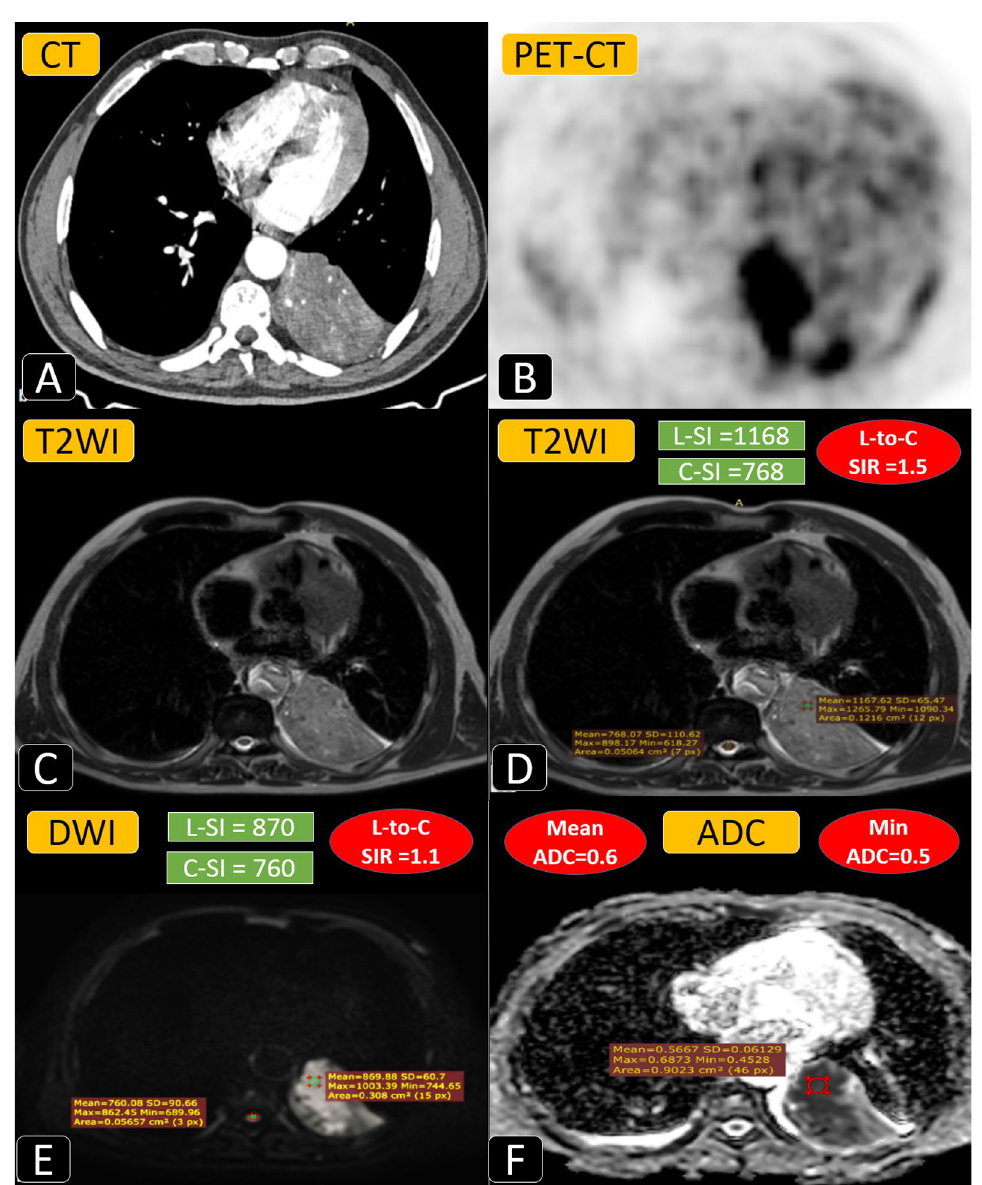
Fig. 5 A 76-year-old male patient complained of hemoptysis and dyspnea. A Axial contrast-enhanced chest CT cut (mediastinal window) showed left medial basal consolidation collapse with internal CT-angiogram and absent air bronchogram with a suspected iso-dense mass lesion. B Axial chest PET-CT image showing high 18F-FDG uptake at most of the lesion. C, D Axial T2WI shows the high signal intensity of the lesion. After placing two ROIs within the largest lesion and the spinal cord, the lesion-to-spinal cord signal intensity ratio was calculated 1.5. E Axial DWI showing = bright signal of restricted diffusion and lesion-to-spinal cord signal intensity ratio was calculated 1.1. F ADC mapping images showing low signal = intensity with minimum ADC (0.5 10 − 3 mm 2 /s) and mean ADC (0.6 10 − 3 mm 2 /s). Referring to the estimated cutoff values, T2WI L-to-SC SI ratio, × × DWI L-to-SC SI ratio, minimum ADC, and mean ADC suggested a malignant process. Pathologically proven small cell lung cancer